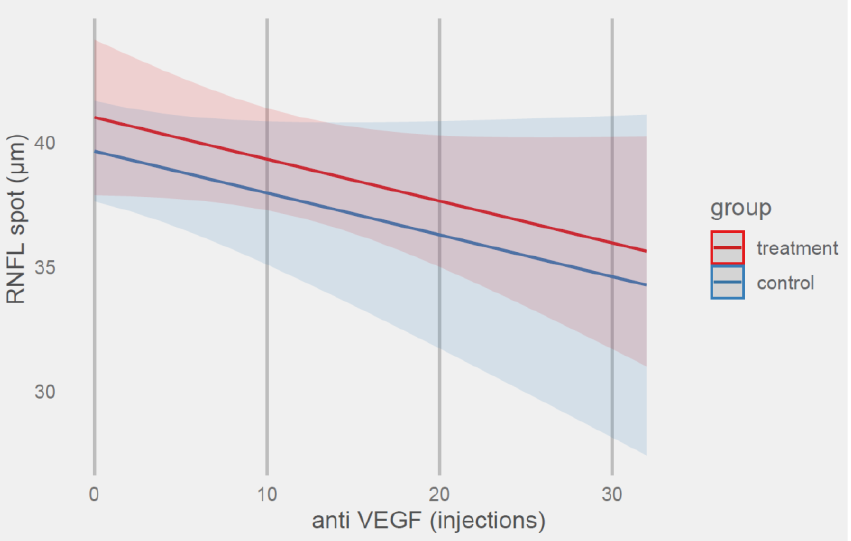
Figure 1. Prediction of RNFL thickness values (μm) by model 1 with anti-VEGF and group terms.